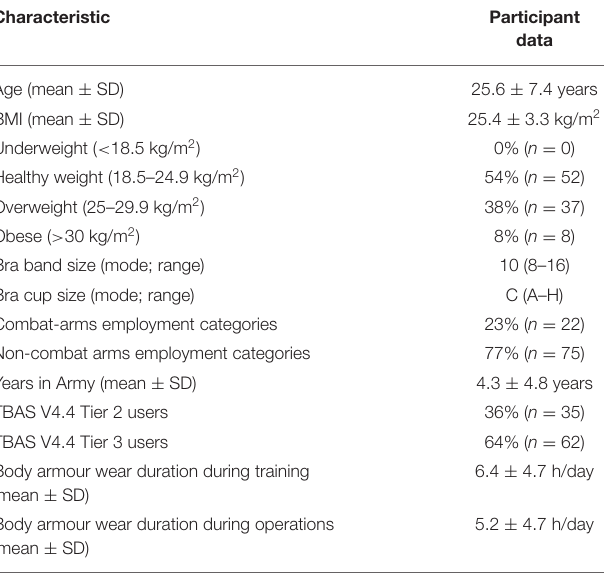
TABLE 1 | Participant characteristics ( n =